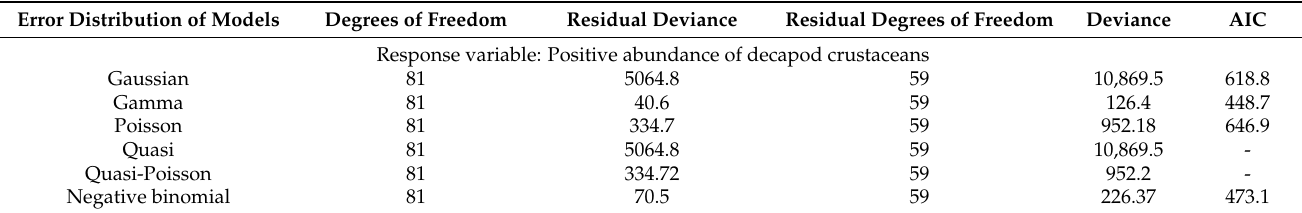
Table 1. Comparison of general linear models with different error distributions to model the positive abundance of decapod crustaceans. Error Distribution of Models